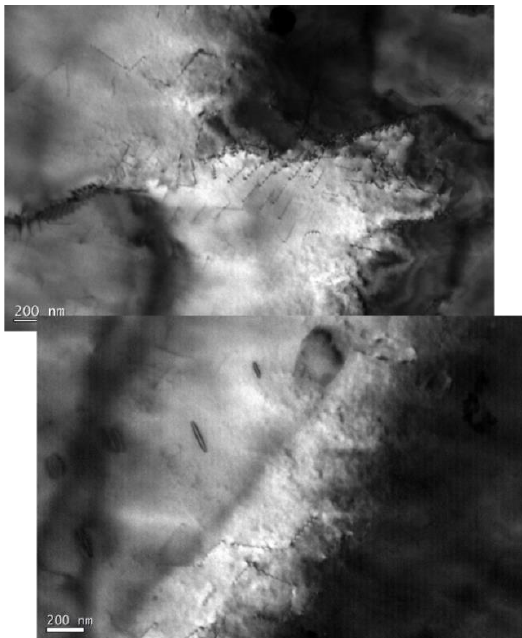
Figure 25. TEM micrograph of the sample irradiated at a low dose and 450 °C showing a large area with a very few dislocation loops and lineal dislocations.